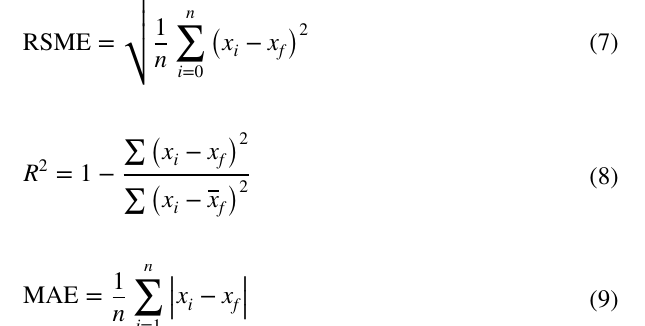
Table 1 Rainfall and streamflow data details of the five selected study areas in Malaysia